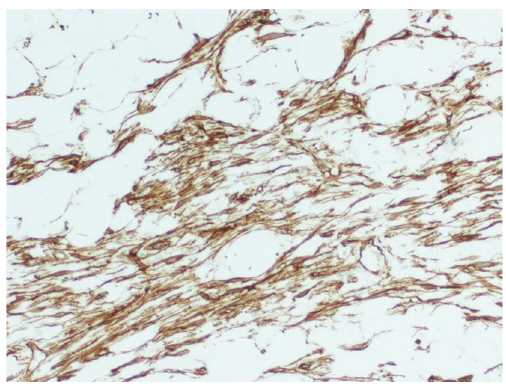
Figure 7: High-power view of more haphazard arrangement of spindle cells within fibrous stroma and mixed with adipocytes (H&E